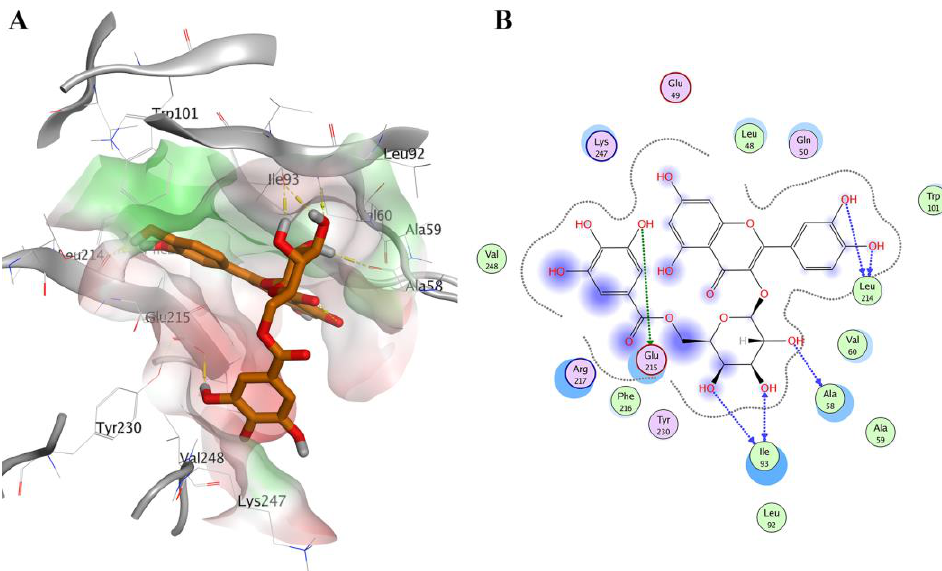
Figure 5. Docking pose of compound CP3756 (NANPDB3—orange sticks) in the Fascin binding site 2 (PDB ID: 6I18), represented by 3D and 2D as ( A , B ), respectively. The color scheme is the same as in Figure 4.